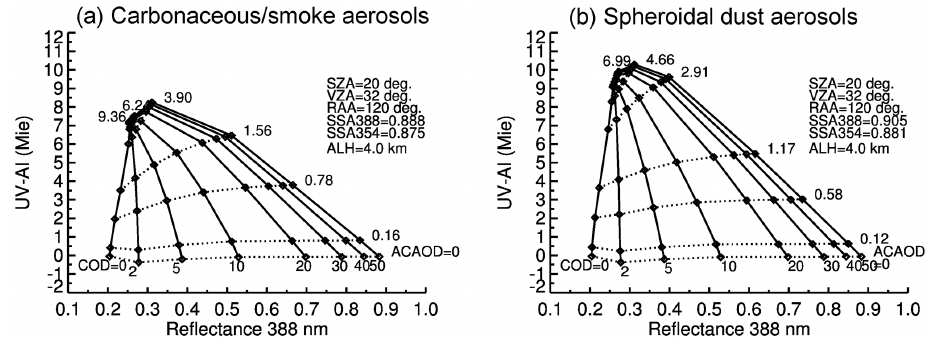
Figure 1. Simulation of UVAI (y axis) vs. reflectance at 388nm (x axis) for the different pairs of ACAOD and COD (both at 388nm) for the carbonaceous (a) and spheroidal shape dust aerosols (b) . Values of ACAOD and COD depicted in the figure correspond to the 388nm wavelength. The shown 2-D diagram forms the retrieval domain in which the observations from OMI are fitted and related to a pair of ACAOD and